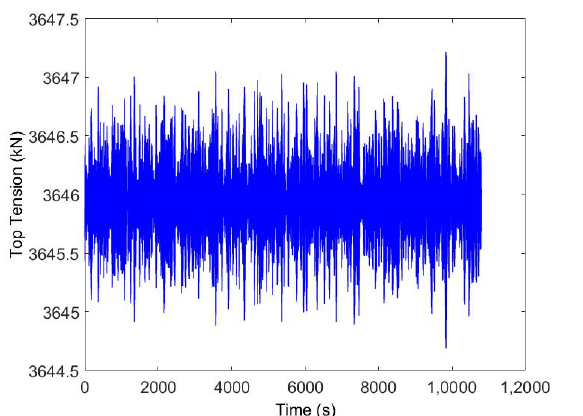
Figure 18. Configuration of the single mooring line.